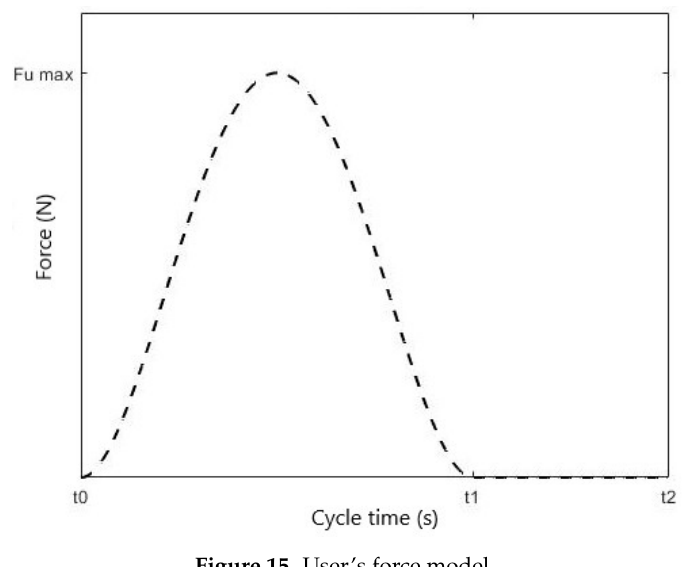
Figure 15. User’s force model.